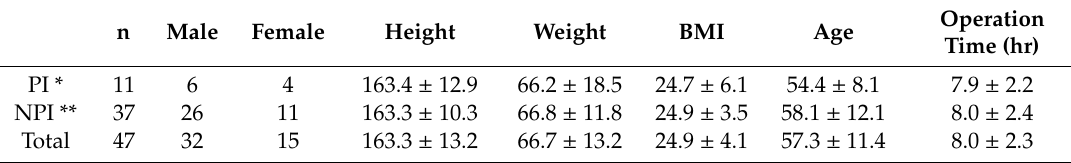
Table 1. Basic information of patients with and without pressure injury.